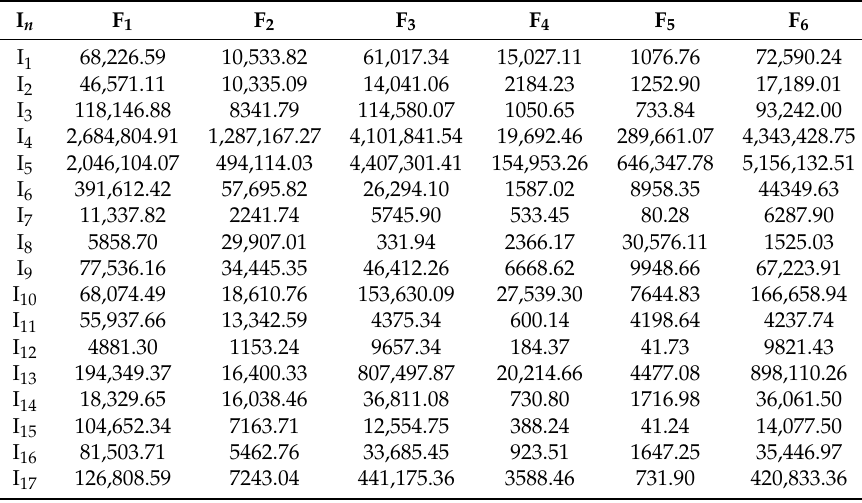
Table 12. Forecast data in